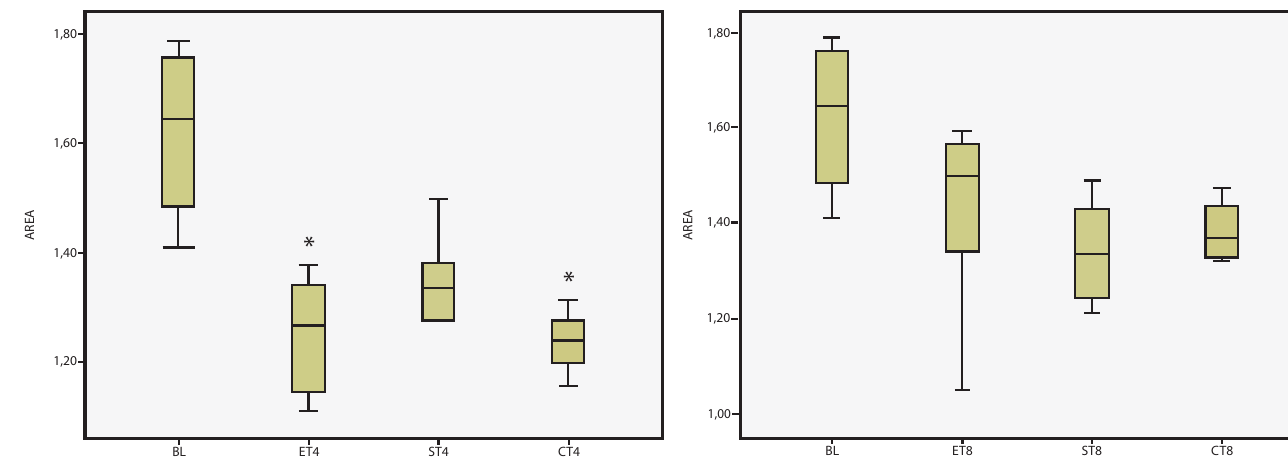
Figure 2: Box-plot with values of area in cm². * Significant difference in relation to the BL group. Evaluation of the BMC (g) showed a significant increase in the ST4, ET8, ST8, and CT8 groups when compared to the ET4 group (Figure 3).